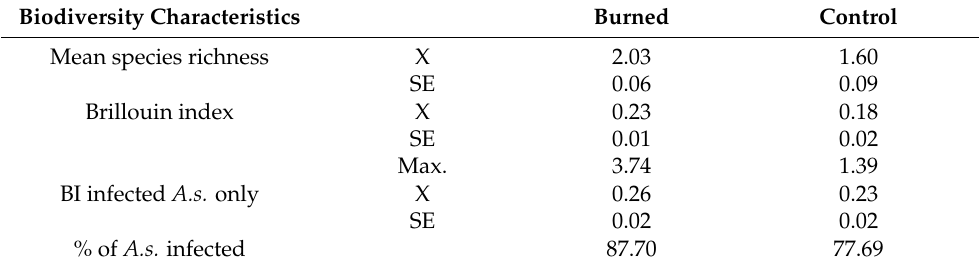
Table 8. Biodiversity characteristics of the helminth community of the wood mouse in the burned and control